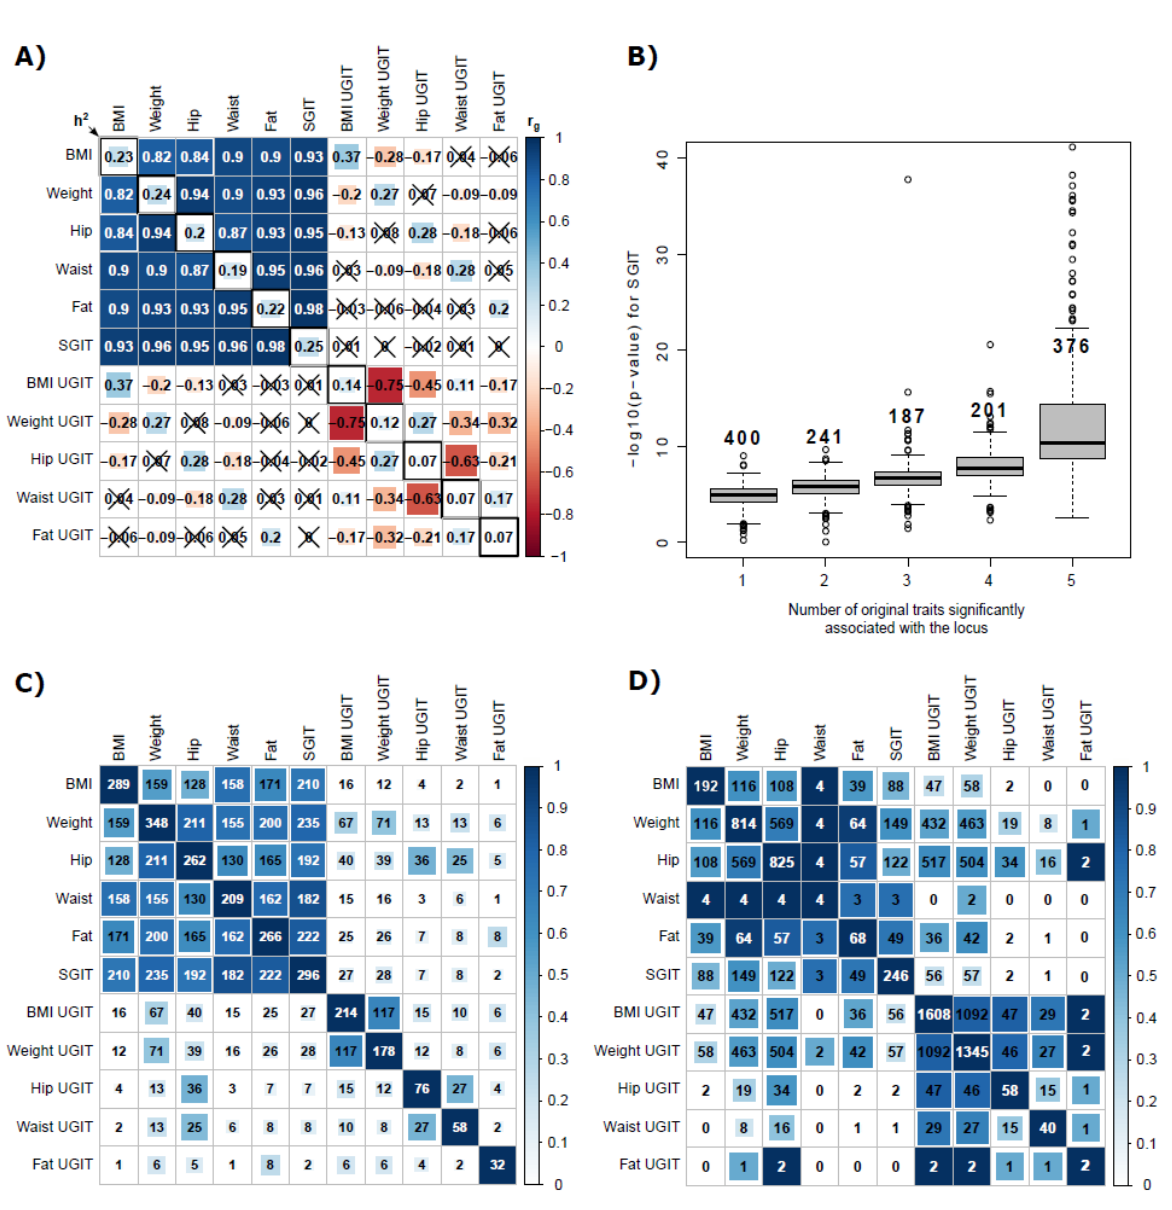
Figure 4. Results of the application of SHAHER to anthropometric traits. ( A ) The heatmap of genetic correlations between the original, SGI and UGI traits. The number, color strength and size of the squares in the matrix show the values of the correlation coefficients between the traits. The diagonal elements represent heritabilities. Crossed out values indicate insignificant correlations. ( B ) Boxplots of − log 10 ( p -value) for the SGIT with respect to the number of the original traits significantly associated with the locus. Two outliers for loci with − log 10 ( p -value) > 40 are omitted. The number at the top of the boxplot corresponds to the number of significant SNPs. ( C ) The heatmap of the numbers of overlapping loci between traits. The numbers in the cells represent the absolute numbers of overlapping loci. The color strength and size of the squares in the cells show the relative scaled number of overlapping loci (on a scale from 0 to 1). The diagonal elements represent the number of loci found for every trait. ( D ) The heatmap of the numbers of overlapping gene sets between traits. The color strength and size of the squares in the cells show the relative scaled number of overlapping gene sets (on a scale from 0 to 1). The diagonal elements represent the number of gene sets found for every